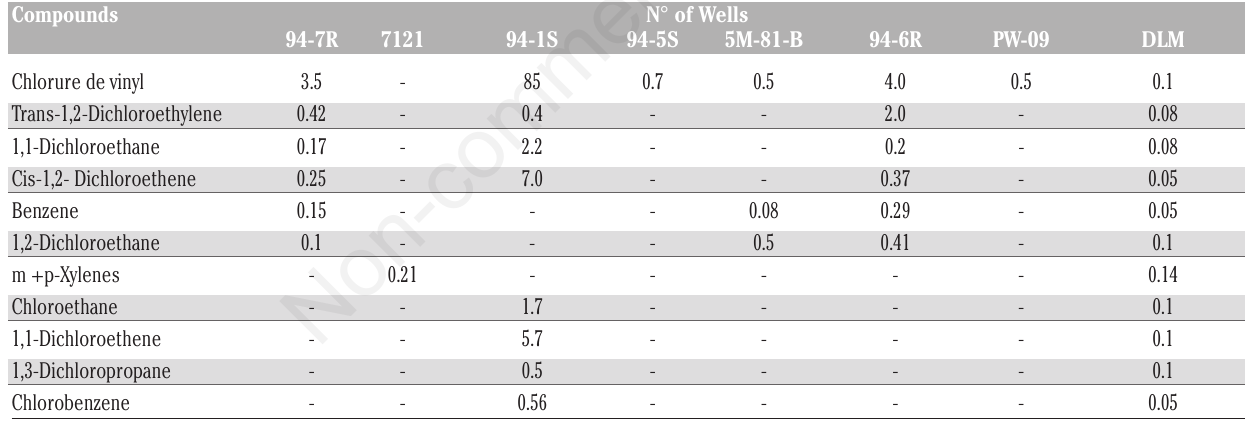
Table 1. Samples of water collected in campaign 2010 from 15 wells in order to study the quality of Mercier groundwater. Analysis showed that approximately half of wells (7 wells) have concentrations of volatiles organic compounds higher than detection limit [(the concentration values (µg/L)]. Vinyl chloride concentrations within a well ranged up to 0.5 ug/L and a maximum concentration of 85 ug/L was recorded in one well. Analyses were provided by the Ce ntre d'Expertise en Analyse Environnementale of the province of Quebec, and determined according to their standard methods (CAEQ,2010) Compounds